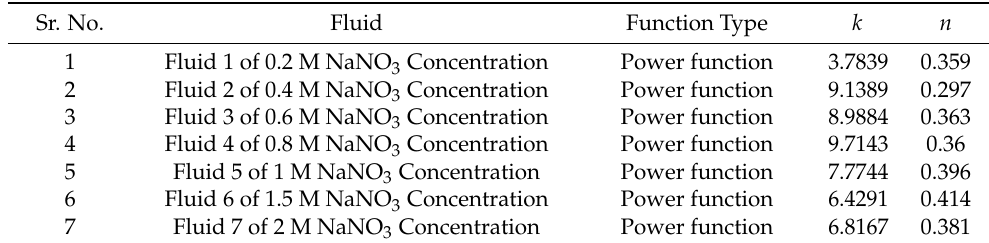
Figure 5. Comparison of viscosity plot of type1 viscoelastic fluids containing 0.8 M and 1.0 M NaNO 3 concentration at different temperatures.